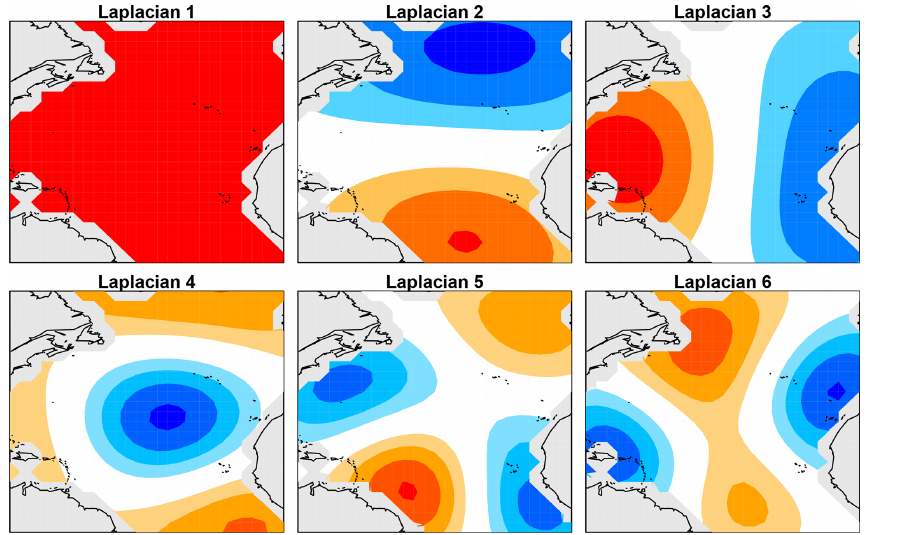
Figure 1. Laplacian eigenvectors 1, 2, 3, 4, 5, and 6 over the North Atlantic between the Equator and 60 ◦ N, where dark red and dark blue indicate extreme positive and negative values, respectively.